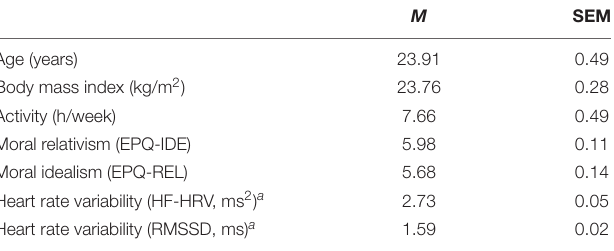
TABLE 1 | Sample characteristics.